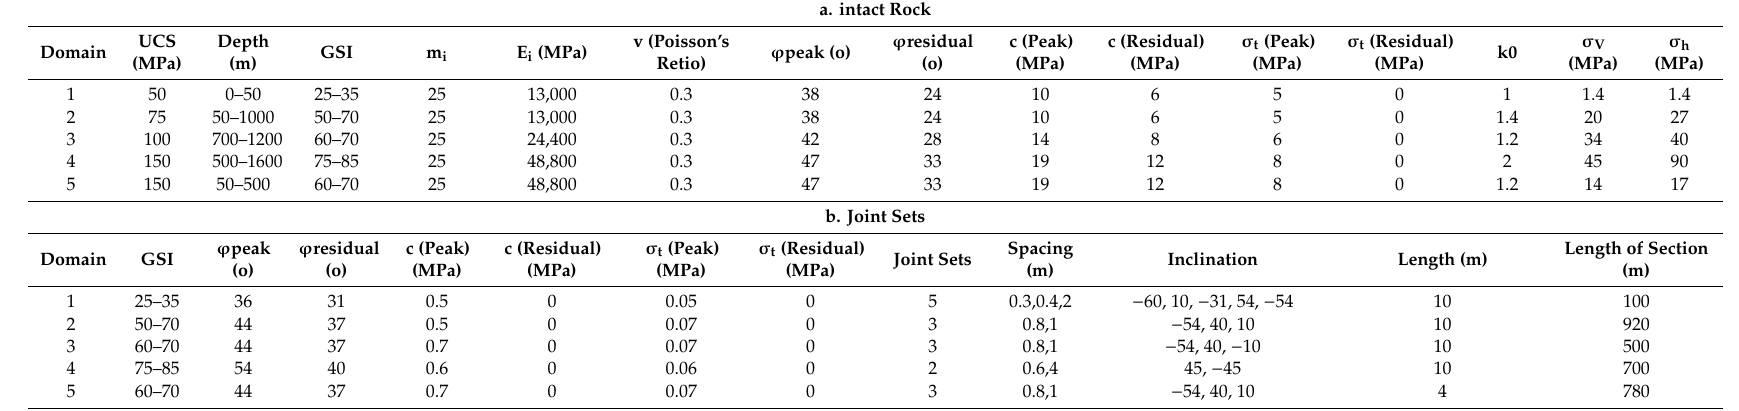
Table 12. Estimated excavation and temporary support measures cost for each Geotechnical Unit. Geotechnical parameters for Scenario I: a. intact rock and, b. joint sets (after